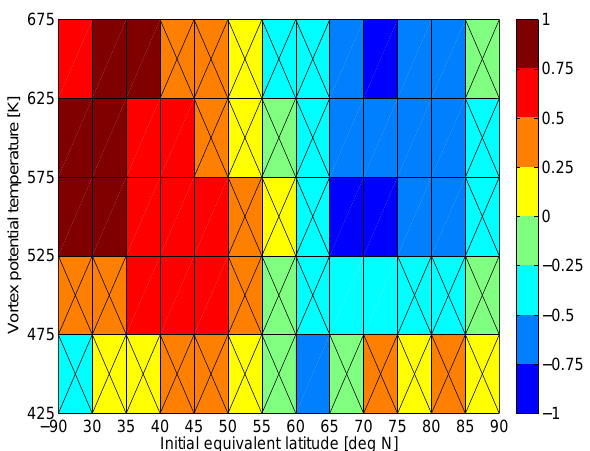
Fig. 9. Correlation of the origin of air inside the polar vortex and vortex mean ozone mixing ratios. Each colored box shows the cor- relation coefficient of a time series of vortex mean ozone mixing ratios in early winter and a time series of an origin tracer in early winter (1992–2009). The ozone time series is averaged over the po- tential temperature layers indicated at the vertical axis. The labels of the axis give the endpoints of the 50K intervals. The time series of the origin tracer is the fraction of vortex air in early winter orig- inating from the equivalent latitude intervals given at the horizontal axis on 1 September and averaged over the potential temperature intervals given at the vertical axis. Correlation coefficients not sig- nificant at the 95% level are crossed out. Time series are detrended.